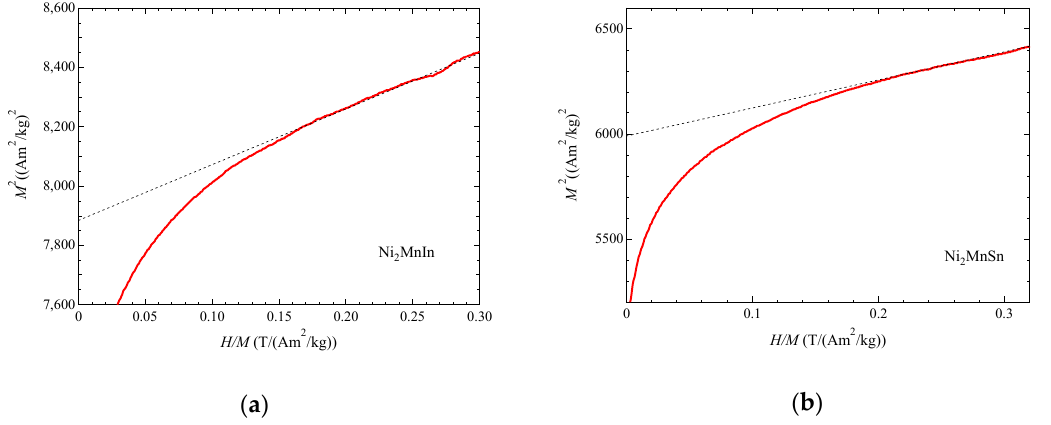
Figure 4. The magnetic field dependences of the magnetization, M 2 vs. H / M at 4.2 K: ( a ) Ni 2 MnIn; ( b ) Ni 2 MnSn. Dotted straight lines are linearly fitting lines.